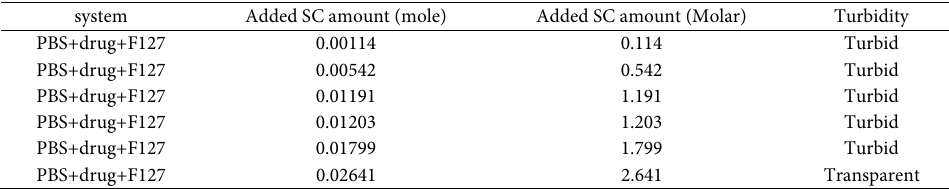
Fig. 4. Optimal binding ratio of oil to F127 in microemulsions Table 4. The added SC amount to the solution of Pluronic F127 and drug in PBS (without oil) to transparency ([F127]=0.009 M, [ * Drug]= 0.09984 M).